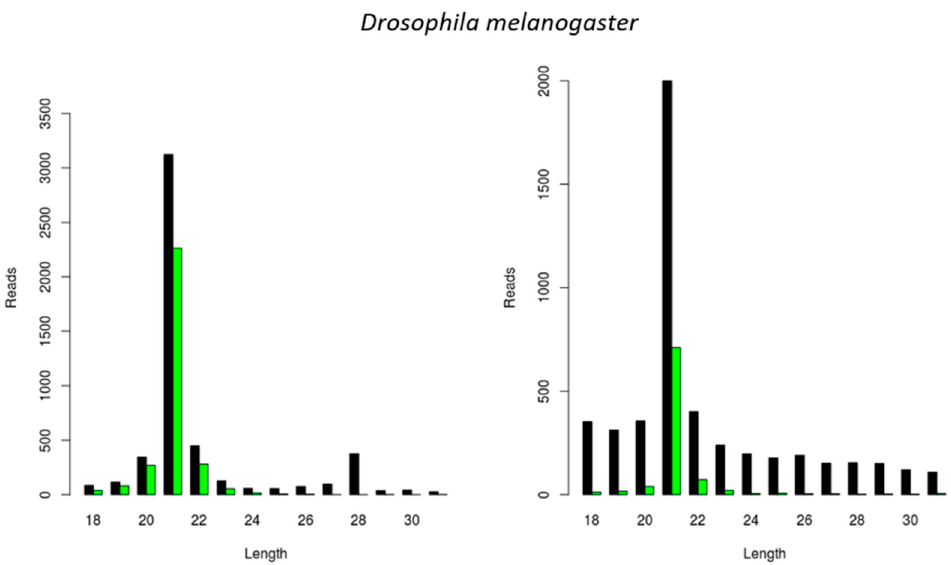
Figure 4. Generation of virus-derived siRNAs in Drosophila melanogaster S2 cells. Length distribution of small RNAs mapping to the Drosophila A virus (DAV) (left) and to the Drosophila C virus (DCV) (right). Reads ( y axis): number of reads. Length ( x axis): length (nt) of the reads. Black: sense reads. Green: antisense reads. To avoid degradation products and general contaminants, reads shorter than 18 nt and longer than 31 nt were not included. Mapping was performed with Bowtie2, and graphs were obtained with the viRome package in R.